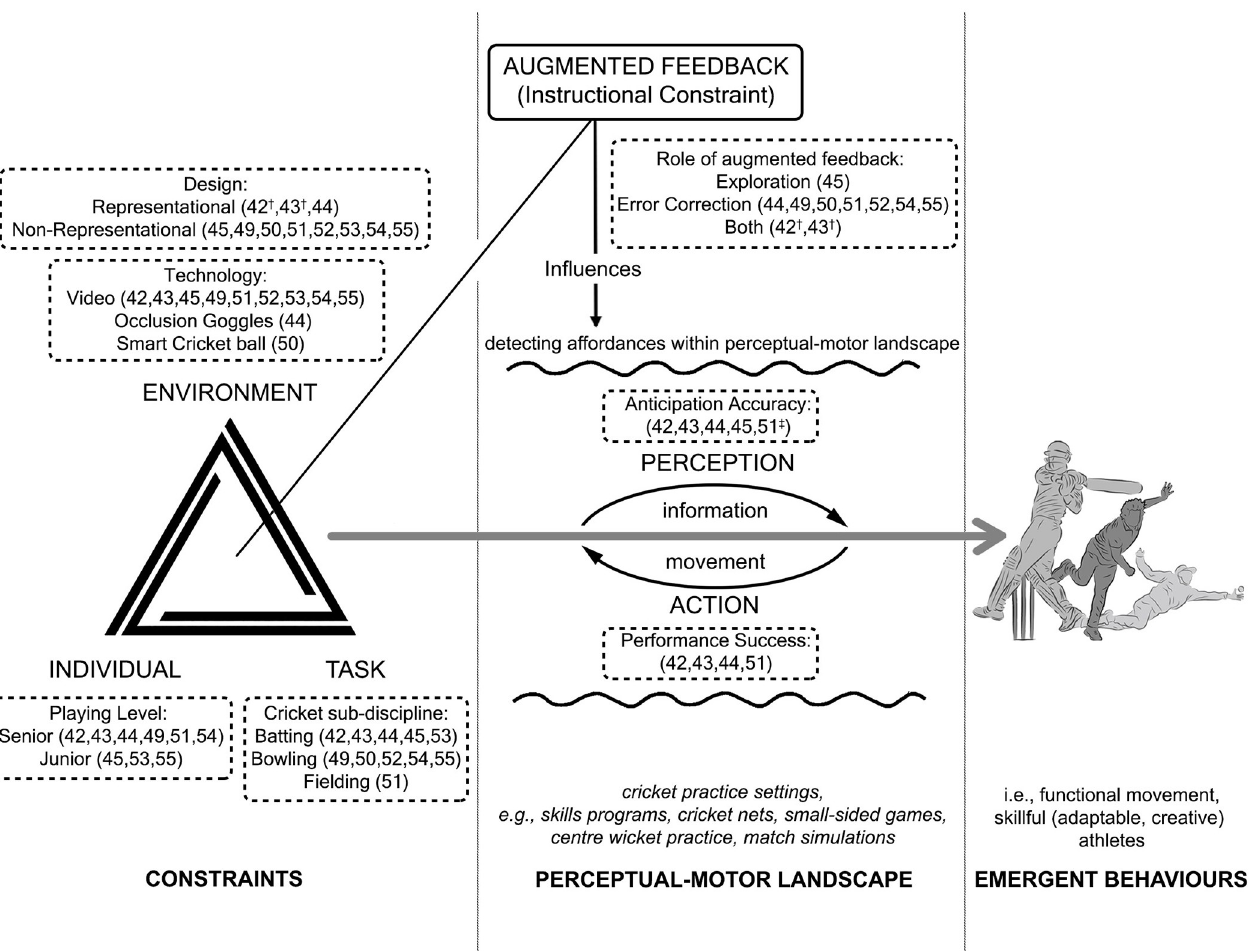
Fig 4. Schematic depicting the ecological dynamics framework and the role of augmented feedback, with reference to studies included in the review. Adapted from Davids et al. [65] and Newell et al. [66]. †some elements of; ‡not included in meta-analysis due to unavailability of data.